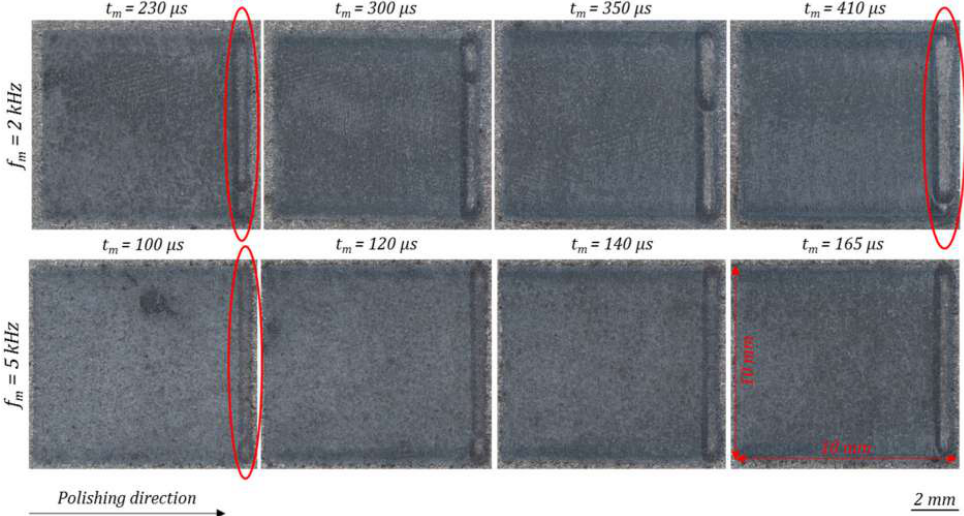
Figure 12. Microscopic pictures of the laser polished surface with a 25-fold magnification considering the used modulation frequencies f m and the modulation time’s t m